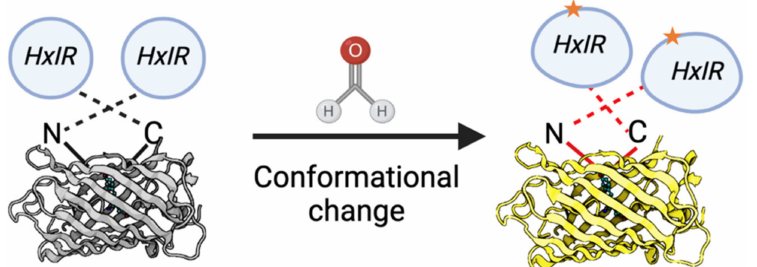
Figure 11. Schematic representation of the FA-sensor FAsor that contains cpYFP flanked with two copies of HxlR. FA induces “N-terminal helix-flipping” in each HxlR unit linking Cys11 and Lys13 residues on the HxlR α 1 helix (crosslinked residues are marked with an asterisk). This event leads to a major conformational change in cpYFP module resulting in an increase in